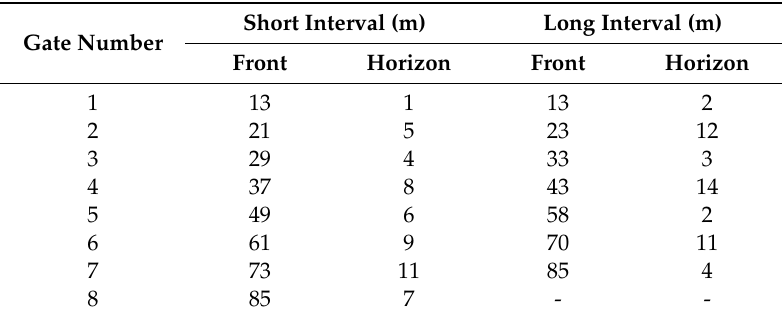
Figure 8. The ski slope and configuration of the gates ( a ) Short interval; ( b ) Long interval. Table 1. Gate distances of the simulation.